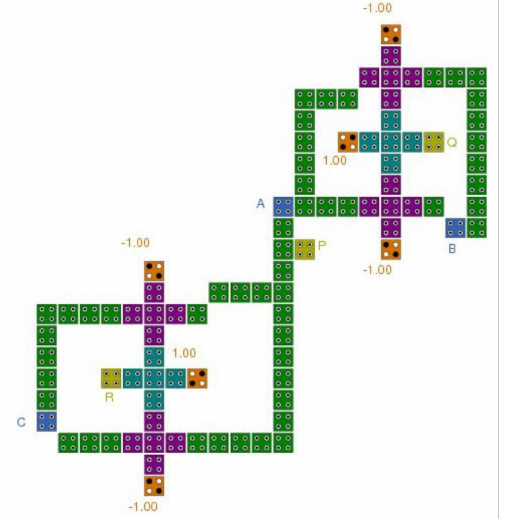
Figure 6. The layout of the Feynman double-gate (proposed by Parhami